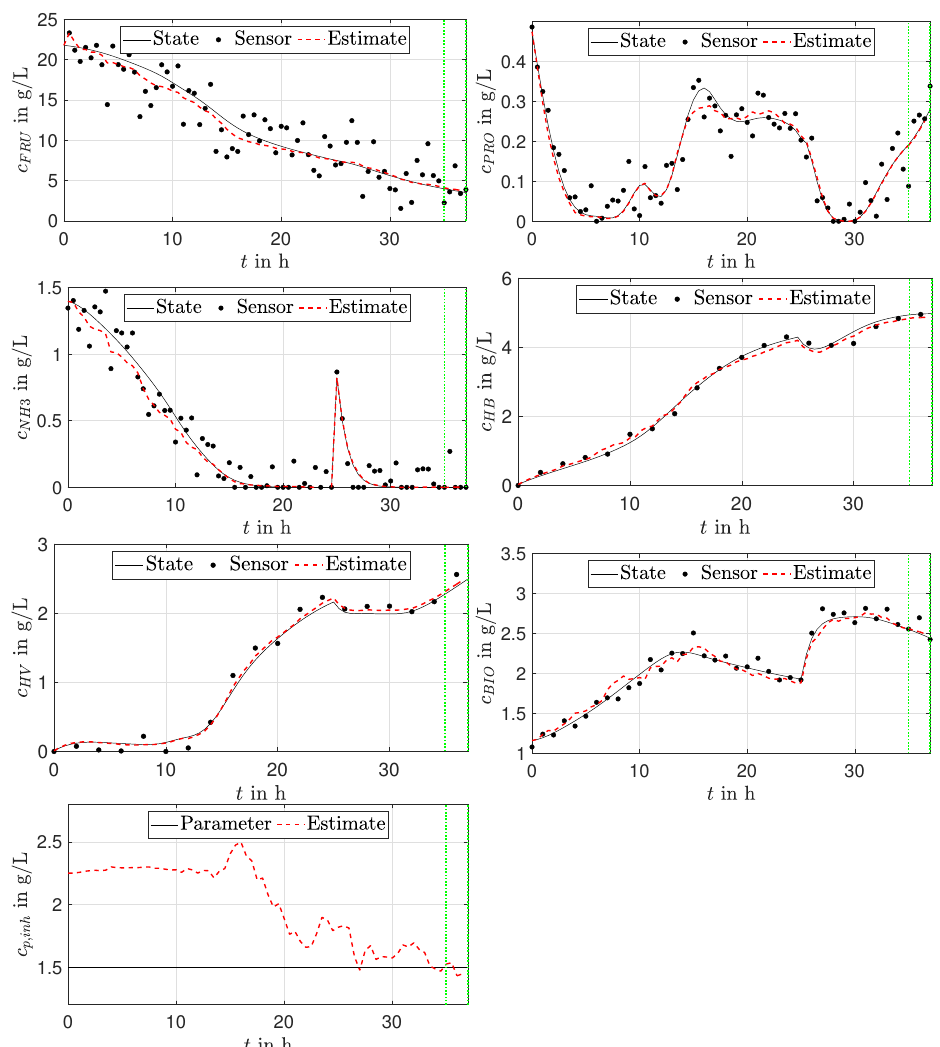
Figure 5. Simultaneous state and parameter estimation for microbial PHA